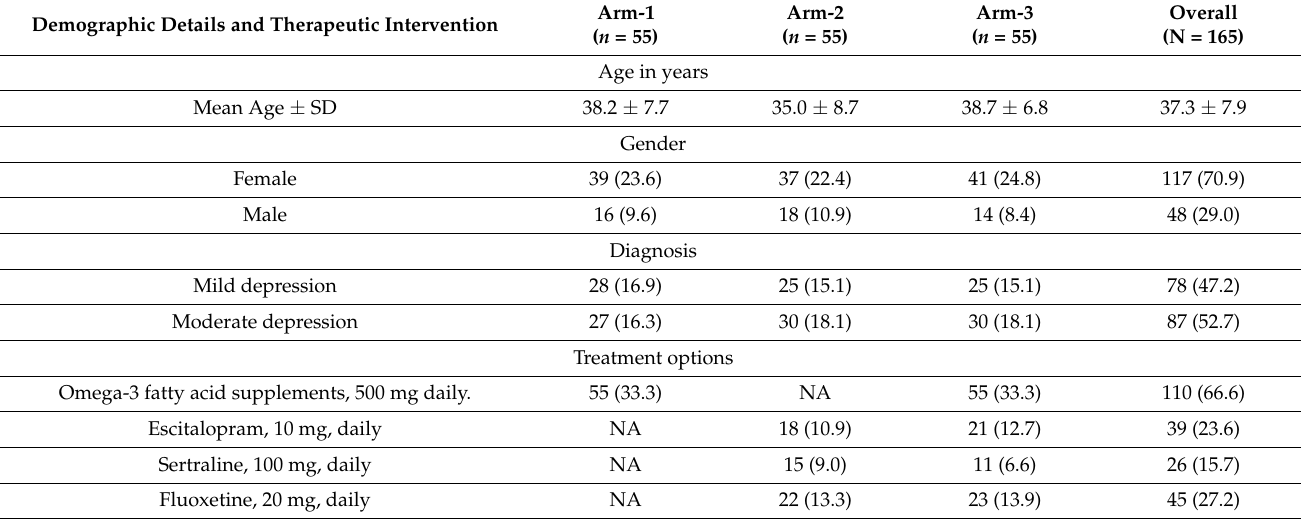
Table 1. Demographic and clinical details of study participants.